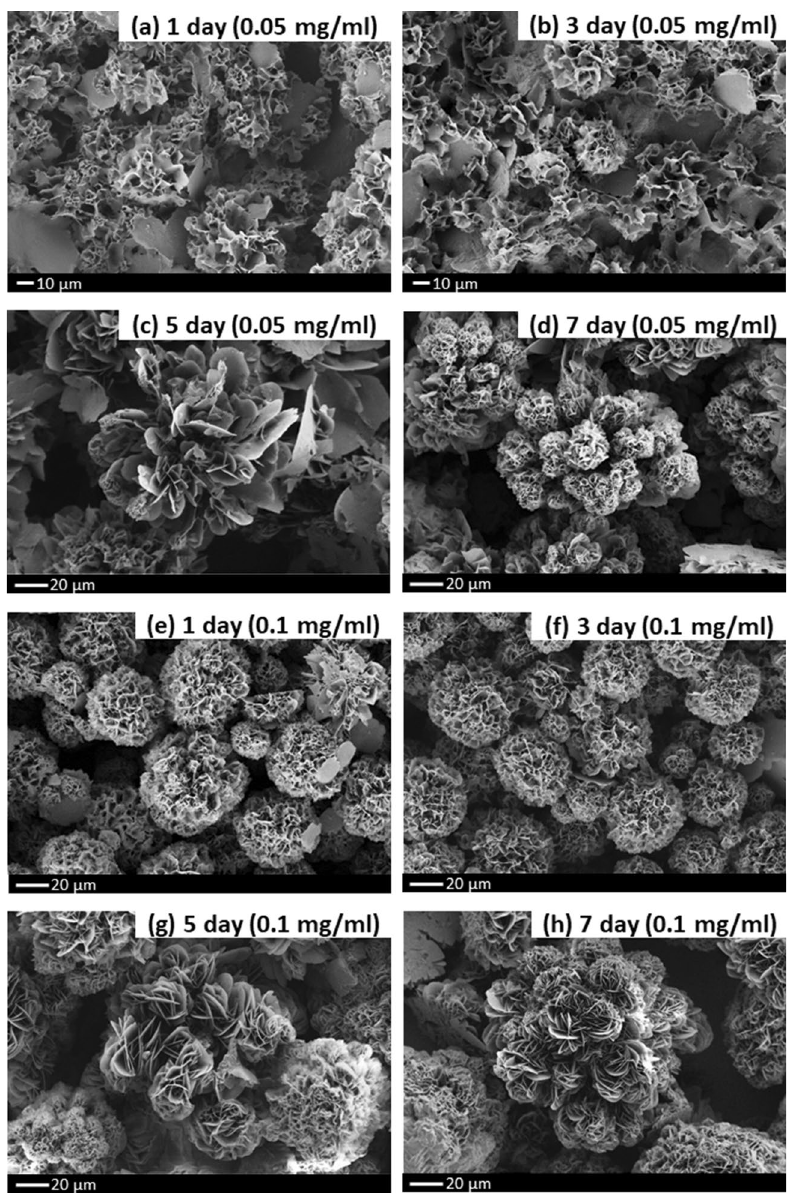
Figure 3. ( a ) FESEM image of CDI-Cu NF synthesized based on different concentrations and incubation periods. ( a – d ) 1, 3, 5, and 7 days of incubation for a CDI with 0.05 mg/ml, ( d – g ) 1, 3, 5, and 7 days of incubation for a CDI with 0.1